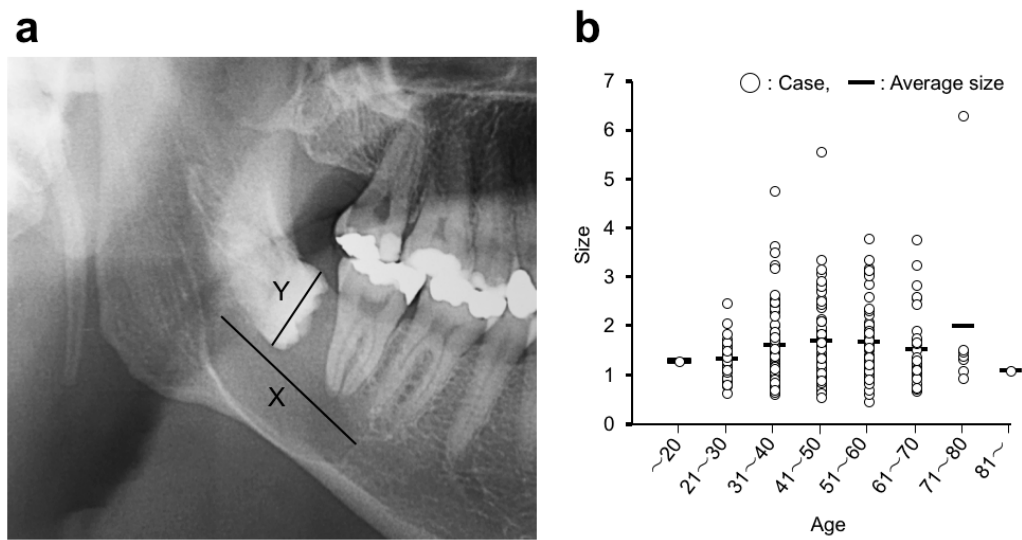
Figure 3. ( a ) The evaluation of the dentigerous cyst size on a panoramic radiograph. Cyst size = Length of the major axis of the radiolucent area (X)/Maximum width of tooth crown of associated third molar (Y). ( b ) Distribution of dentigerous cyst sizes.